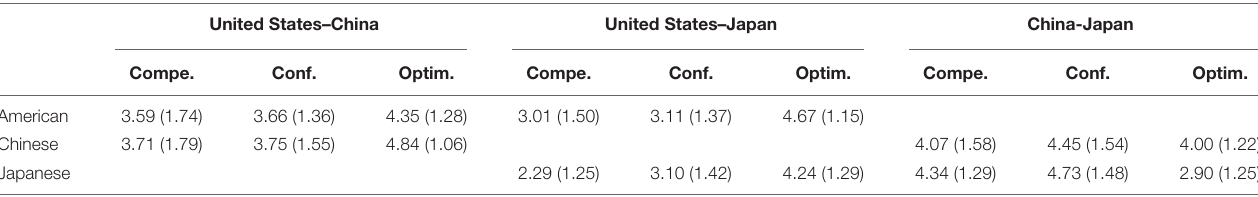
TABLE 1 | Preexisting perceptions of bilateral relations reported by American, Chinese, and Japanese participants. United States–China United States–Japan China-Japan